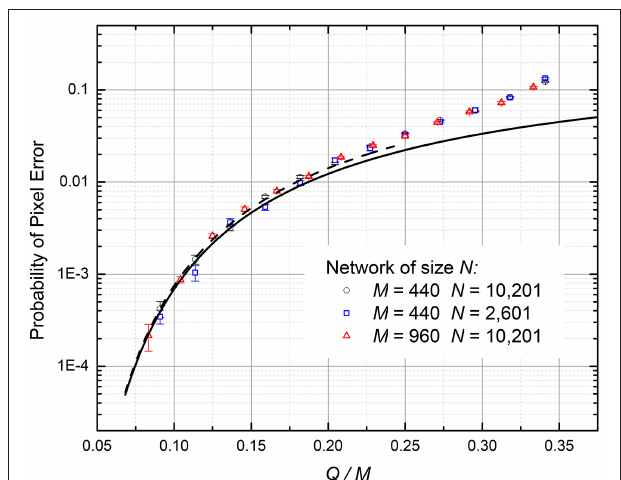
FIGURE 5 | The probability of pixel retrieval error in the ASTM using the Hebbian recording (Equation 3), as a function of the normalized number Q of the recorded frames. Lower curve: Equation (10). Dashed curve: Equation (11), valid only for small probability of pixel errors. Upper points: numerical simulation results, which automatically take into account the induced errors.